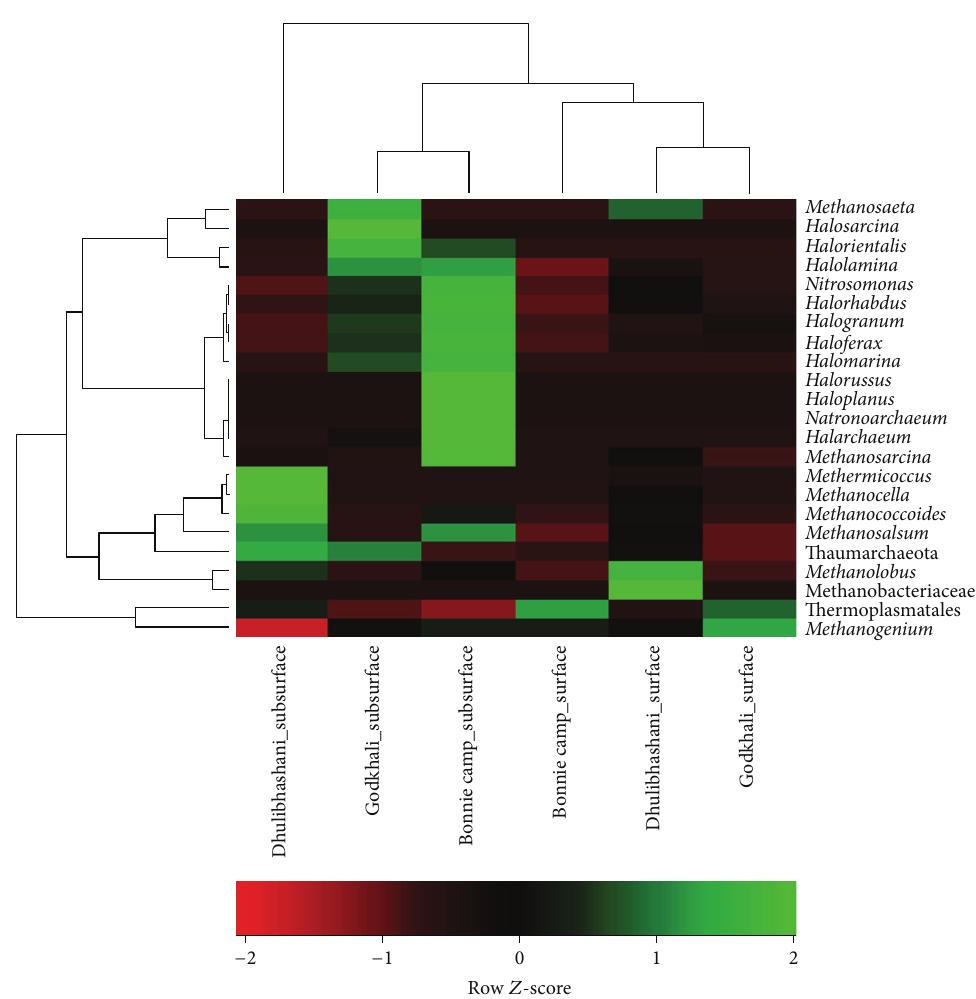
Figure 2: Hierarchical clustering (complete-linkage) heat map generated from taxonomic abundance profile (using Spearman’s rank correlation) reflecting spatial distribution of archaeal class in the sediment of Sundarbans (using Pearson’s